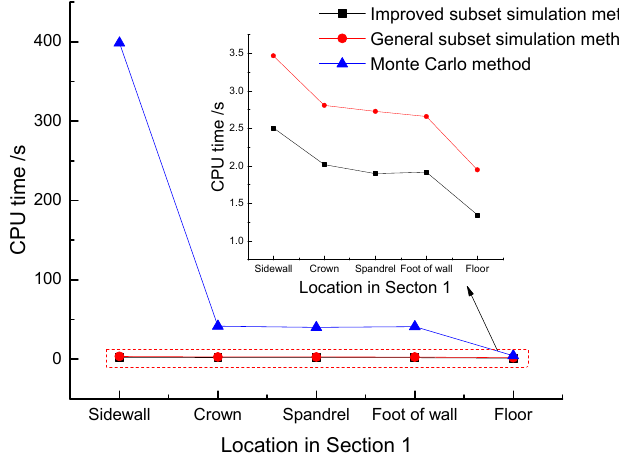
Figure 13. Contrast analysis of the calculation efficiency of the methods.